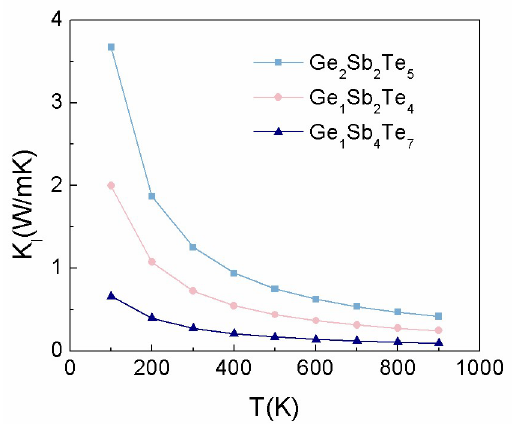
Figure 5. The calculated lattice thermal conductivity of c -GST alloys, for which the structures are reconstructed based on the (111) plane and along the [111] direction of the rock-salt structure. Herein, c axis is along the out of plane direction.